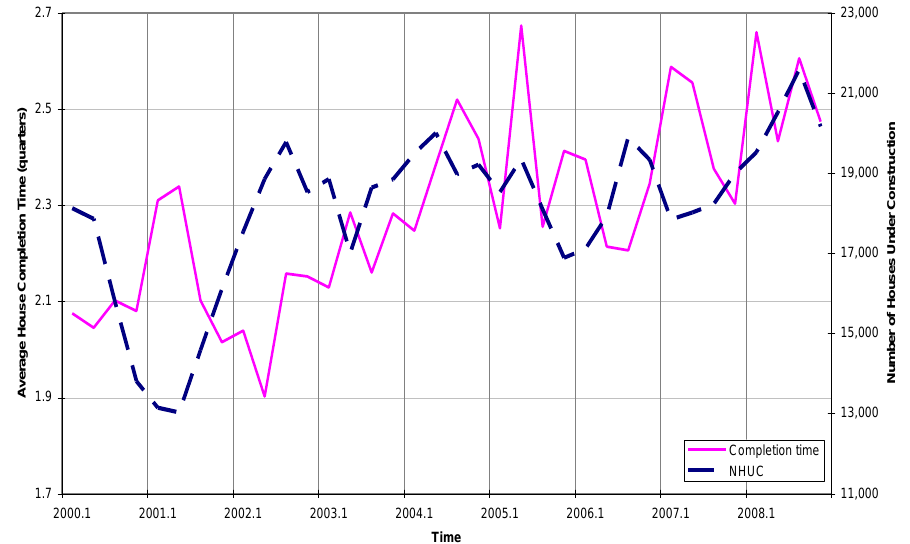
Figure 9: Number of houses under construction and the average house completion time in